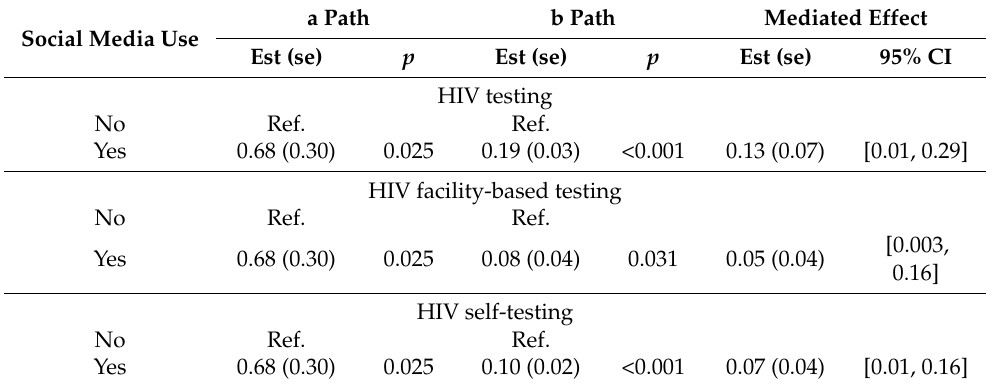
Figure 2. The path of the mediated effect of HIV testing self-efficacy in the relationship between social media use and HIV testing. Table 5. Mediation effect of HIV self-efficacy between the relationship between social media use and HIV testing.